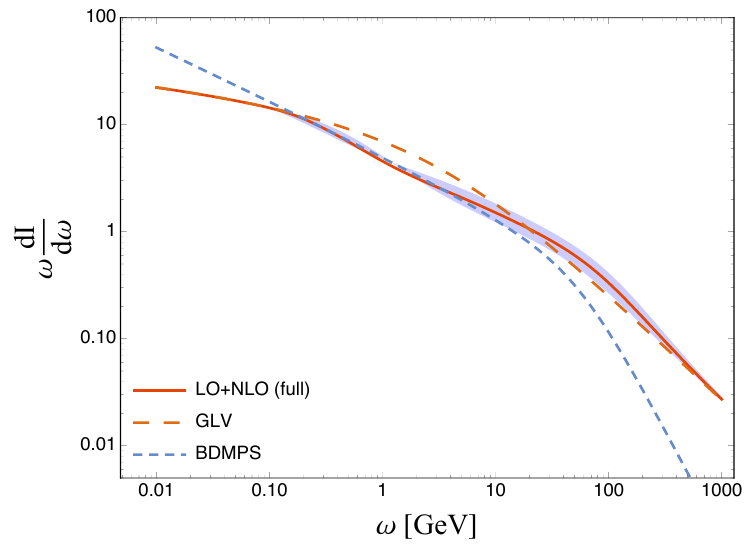
Figure 1 . The eikonal spectrum (assuming x (cid:28) 1) up to next-to-leading order, compared to GLV and BDMPS for a jet with energy E = 1000 GeV. Medium parameters are ^ q = 1 : 5 GeV 2 /fm, (cid:22) = 1 GeV and L = 4 fm.